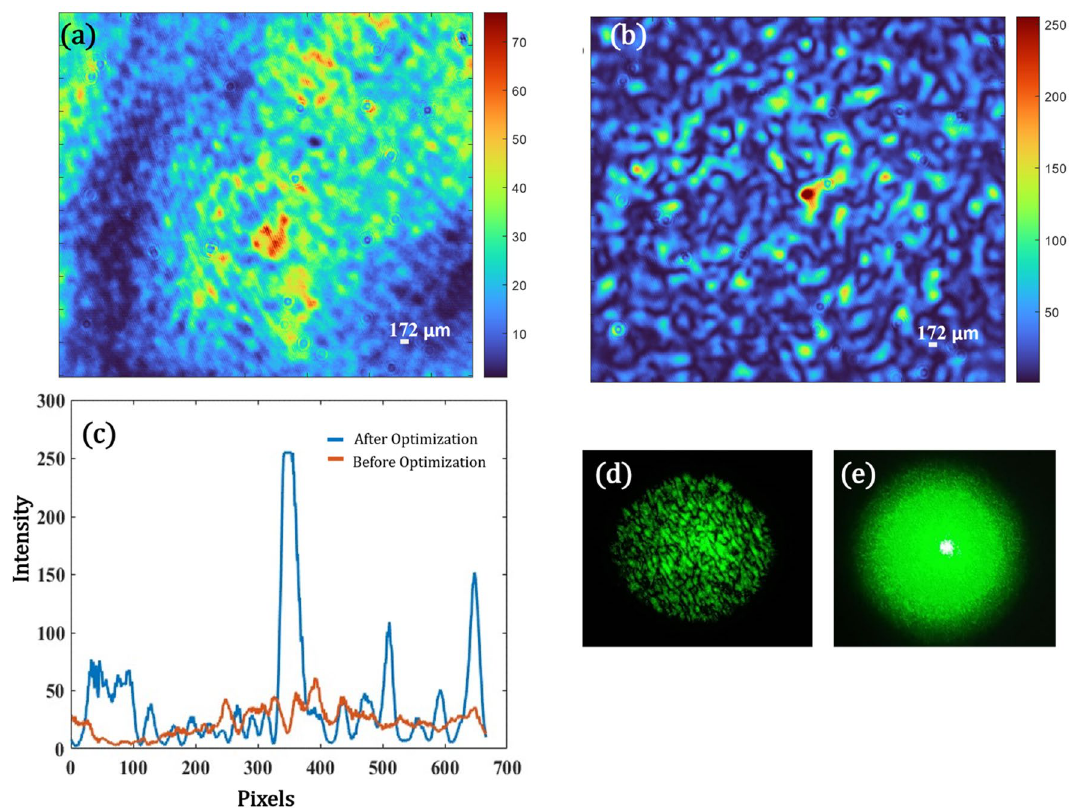
Figure 6. ( a ) Scattered Speckle pattern on CAM2 when the diffuser is illuminated with a plane wave at a distance of (z = 100 mm) from the diffuser, ( b )The optimized focus after optimization, ( c ) Intensity profile along an axis for both ( a ) and ( b ) marked in red and blue respectively, ( d ) Photo taken on a smartphone of the case ( a ) on a screen, ( e ) Photo taken on a smartphone of the case ( b ) on a